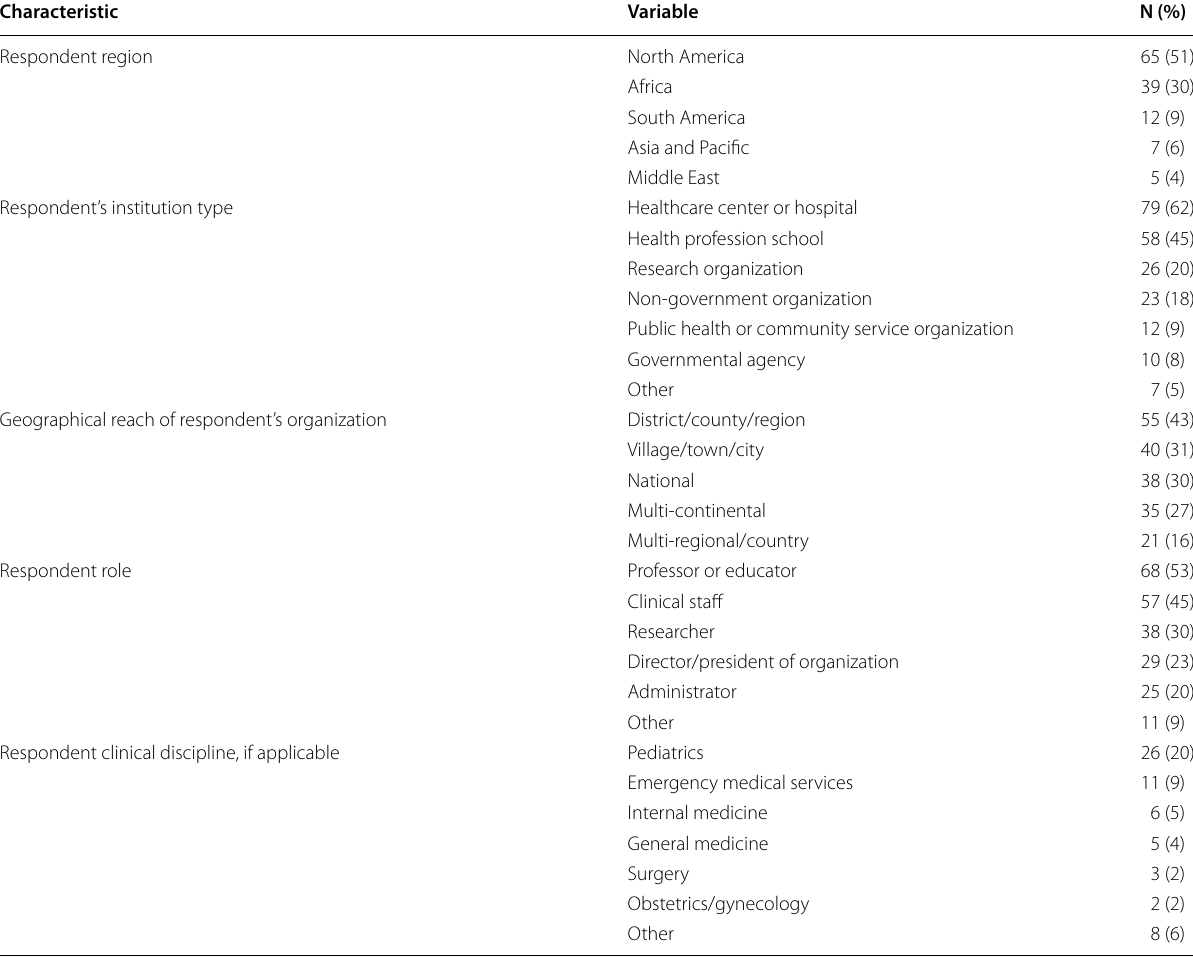
Table 1 Characteristics of eligible respondents to virtual global health partnership initiative survey